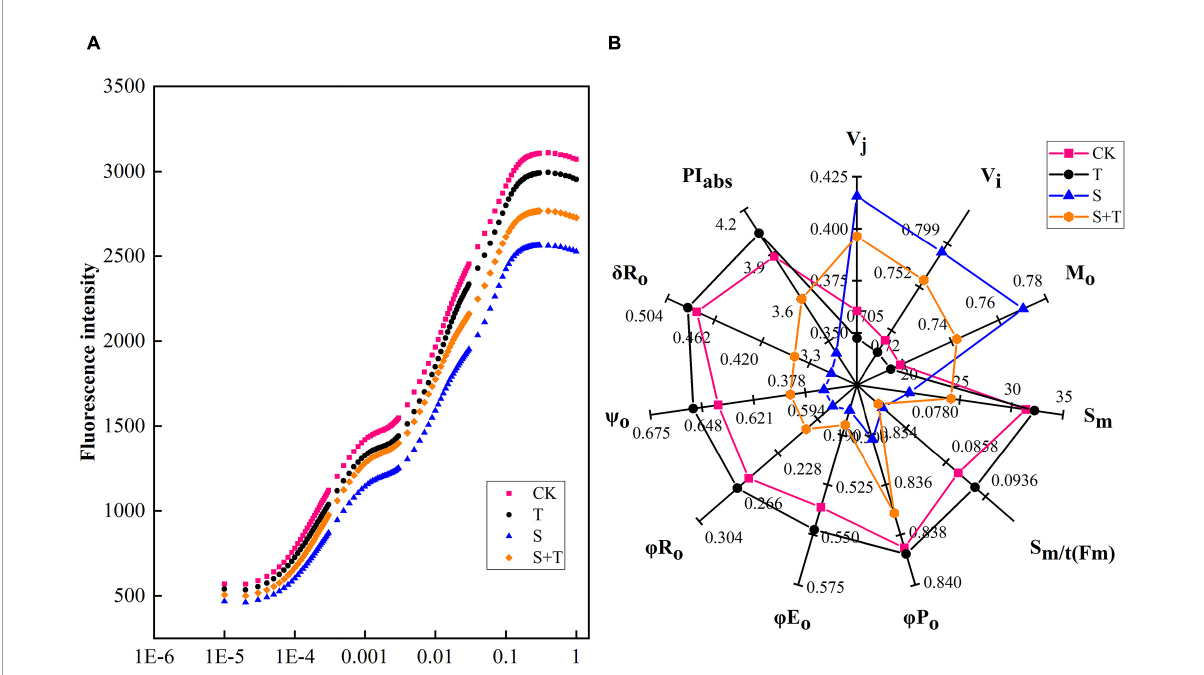
FIGURE5 Effects of Tre treatment on chlorophyll fluorescence kinetics (OJIP curves) and JIP-text parameters of tomato seedlings exposed to salt stress for 5 days. (A) OJIP curves. (B) JIP-text parameters. The results showed the mean ± SE of three replicates. CK, control; T, 10 mM Tre; S, 150 mM NaCl; S+T, 150 mM NaCl + 10mM